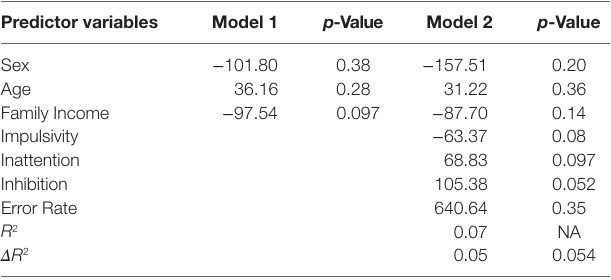
Table 5 | Sequential regression analysis of predictors of social studies